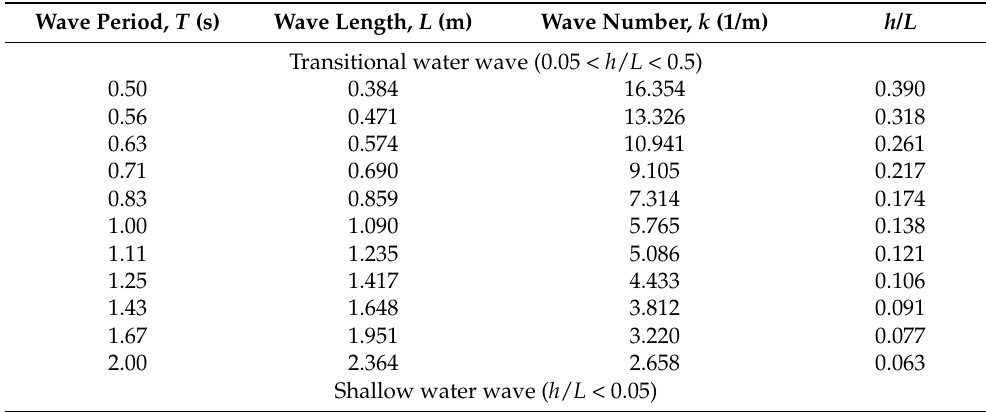
Figure 3. Schematic of the vegetation model and its side view. Table 1. Relevant physical characteristic for the considered wave conditions (incident wave height H i = 3 cm, water depth h = 0.15 m).